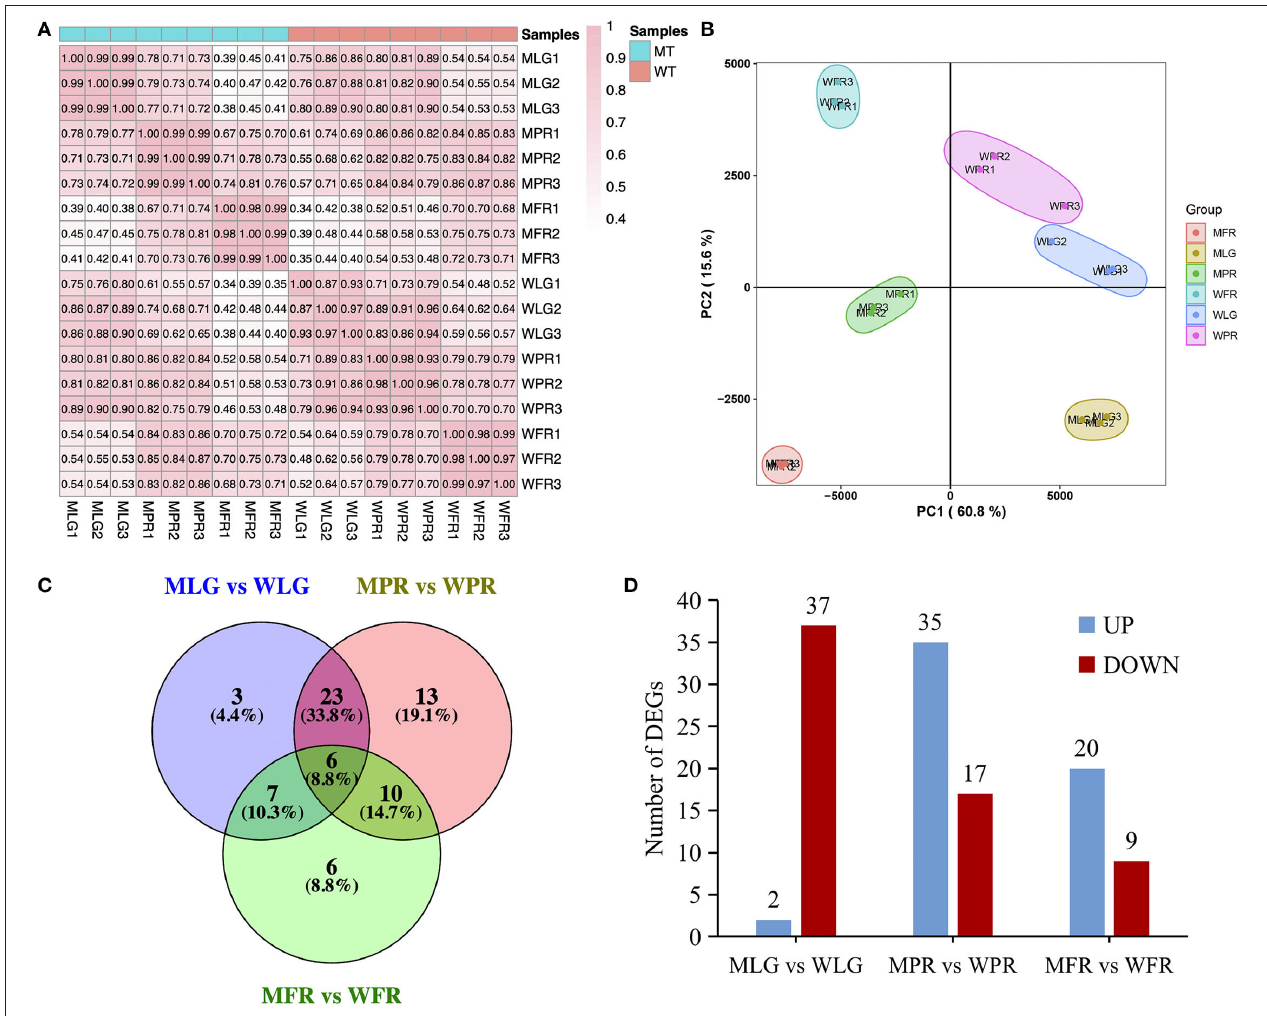
FIGURE 7 | Comprehensive analysis of transcriptome data. (A) Pearson correlation analysis of samples used for RNA-seq. (B) PCA plot for the transcriptome data. (C) Venn diagrams showed the overlap of DE FRG in MT and WT fruits. (D) The numbers of significantly up-regulated and down-regulated genes in the different developmental stages of MT comparing with WT. LG, large green; PR, partial red; FR, fully